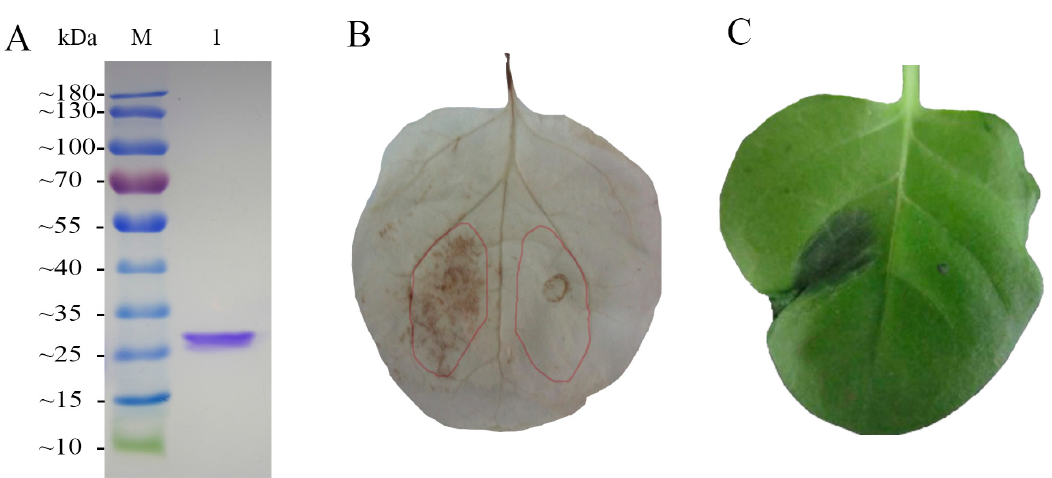
Figure 5. H 2 O 2 accumulation and HR in tobacco following p20 treatment. ( A ) Purification of recombinant p20. The proteins were resolved on SDS-PAGE with Coomassie brilliant blue R-250 staining. Lane M , protein molecular mass marker; Lane 1 , p20; ( B ) Observation of H 2 O 2 accumulation in N. benthamiana leaves. The left side of the leaf was injected with p20 and the other side was injected with BSA as a negative control. The infiltration extent was drawn onto the leaf right after infiltration and marked in the picture; ( C ) Hypersensitive response induced by p20 in N. benthamiana . P20 (left side) and Tris-HCL (right side) were injected into same leaf. The hypersensitive response was observed at 24 h postinjection.